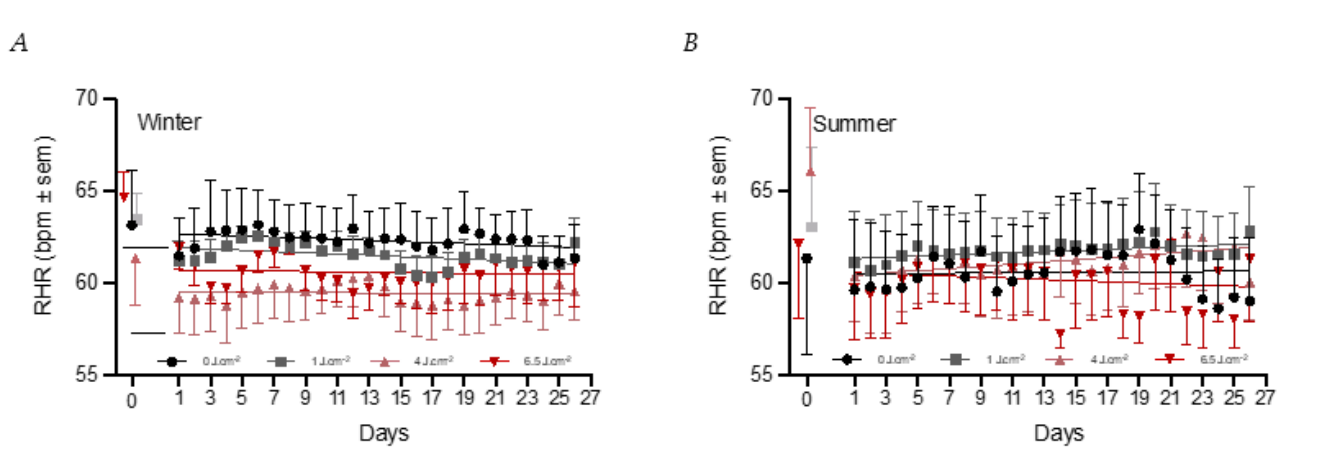
Figure 6. Daily RHR during the four week period. The baseline values are shown on the left side. The black circles represent the 0 J·cm −2 condition (n = 7:6 for winter and summer), grey squares the 1 J·cm −2 condition (n = 7:7 for winter and summer), pink triangles the 4 J·cm –2 condition (n = 8:7 for winter and summer), and red triangles the 6 J·cm –2 condition (n = 8:6 for winter and summer). ( A ) shows the data in the winter group and ( B ) of the summer group.